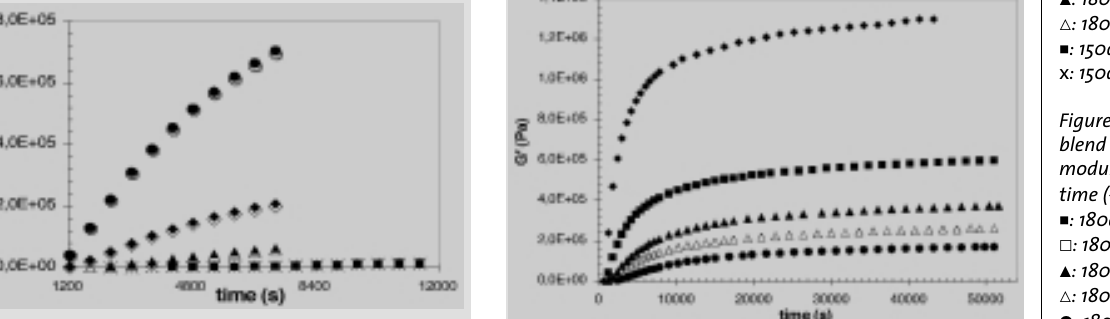
Figure 5 (right): Influence of blend composition. Storage modulus versus